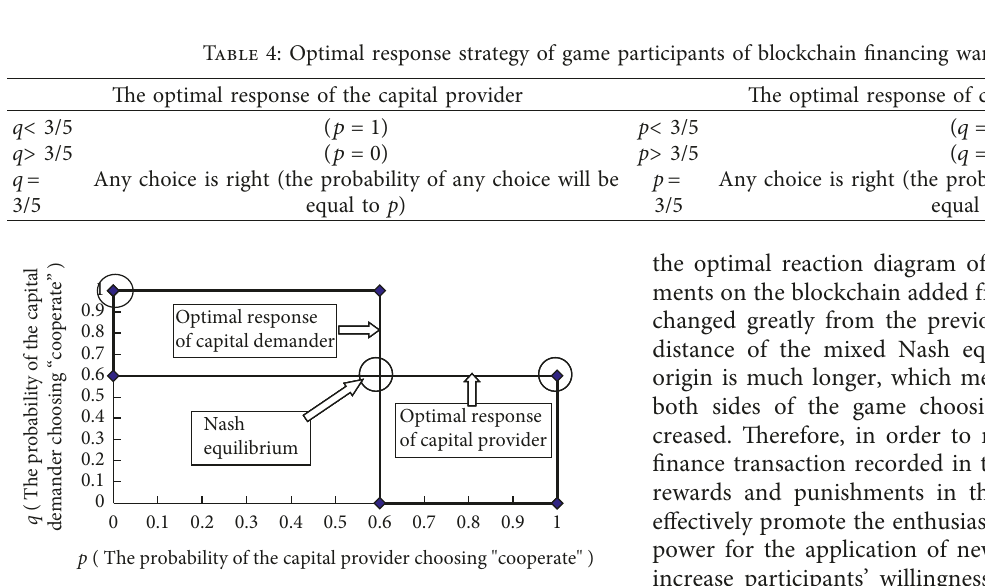
Figure 5: Optimal response strategy of game participants on